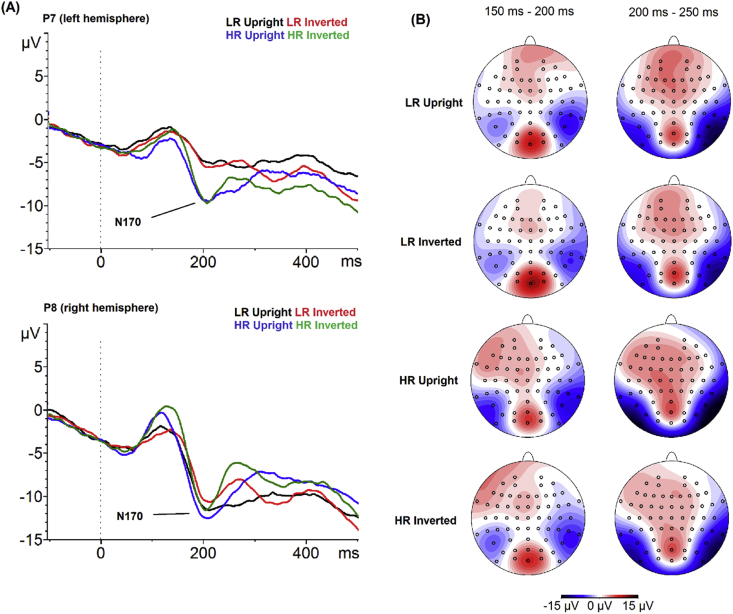
Grand average waveforms and topographical plots for the N170 component by group and condition. Panel (A) shows the grand average stimulus-locked waveforms displaying the N170 ERP component for upright and inverted faces by HR and LR group at electrode P7 (left hemisphere, top) and electrode P8 (right hemisphere, bottom). Black line = Grand average for the upright face condition in the LR group. Red line = Grand average for the inverted face condition in the LR group. Blue line = Grand average for the upright face condition in the HR group. Blue line = Grand average for the inverted face condition in the HR group. Panel (B) shows the topographical maps of the N170 component by group (LR, HR) and condition (upright and inverted faces).